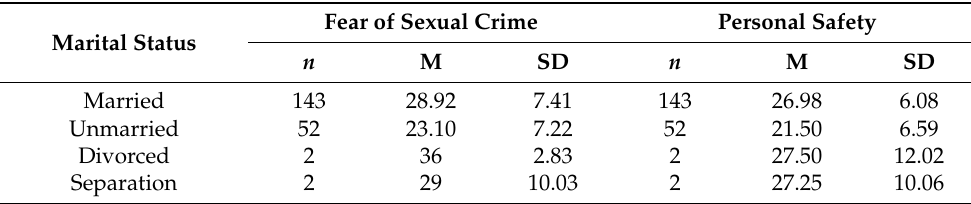
Table 10. Mean and standard deviation of fear of sexual crime and personal safety according to the marital status of the participants.